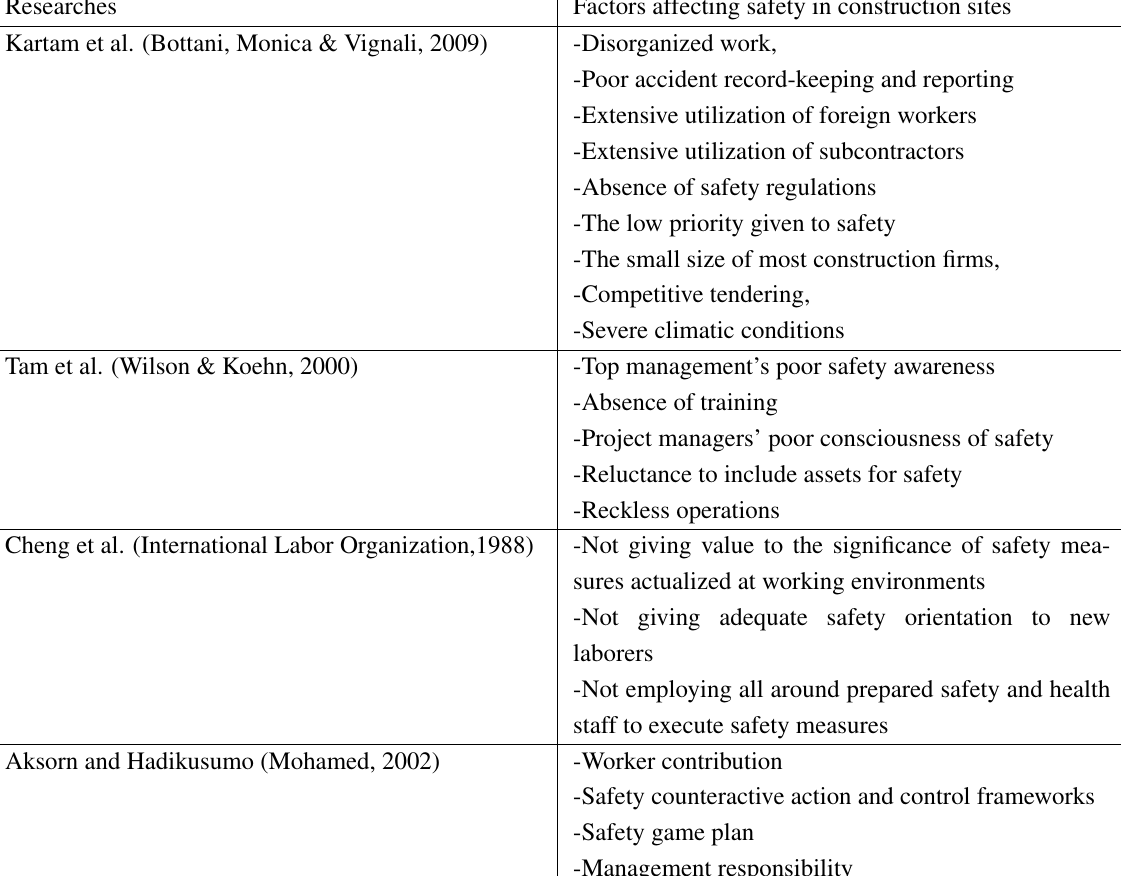
Table 2. FactorsAffecting Safety in Construction Sites